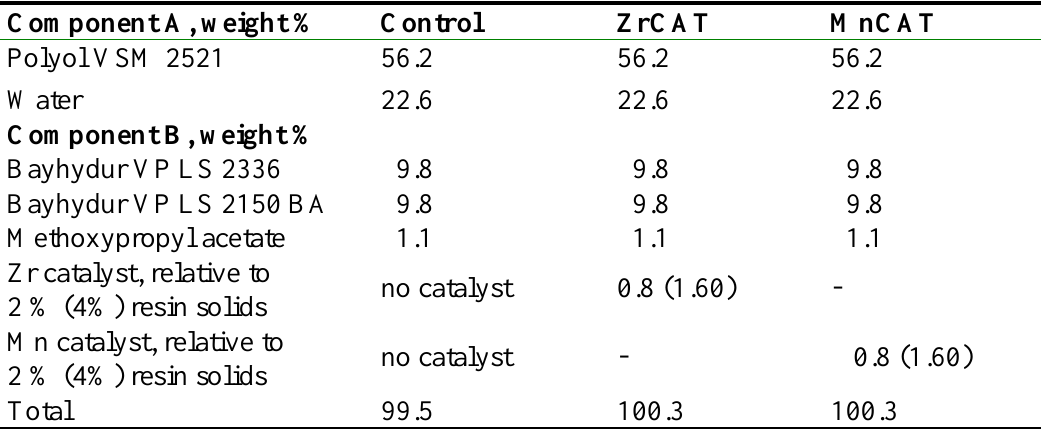
Table 2 . The composition of the two-component aqueous polyurethane (aqPUR2) sample based on the polyol component Macrynal VSM 2521 w/42 WAB (coating hardness 40.2